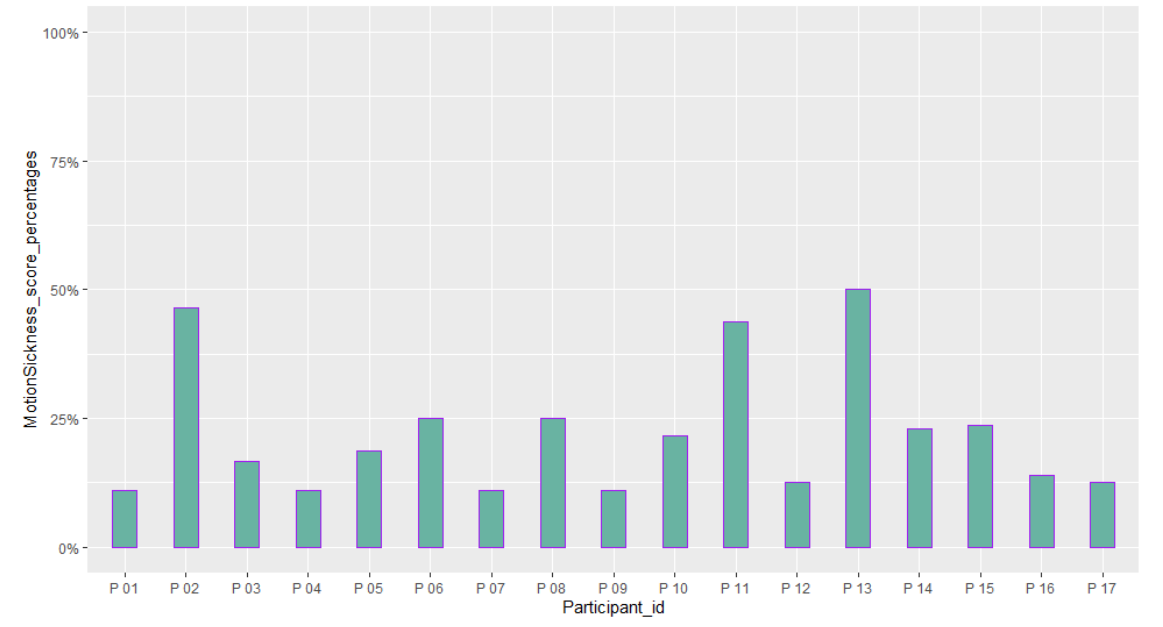
Figure 19. A comparison between the scores obtained from the participants from the Motion Sickness questionnaire (MASQ) (M = 22.18 (%), SD=12.84 (%)).